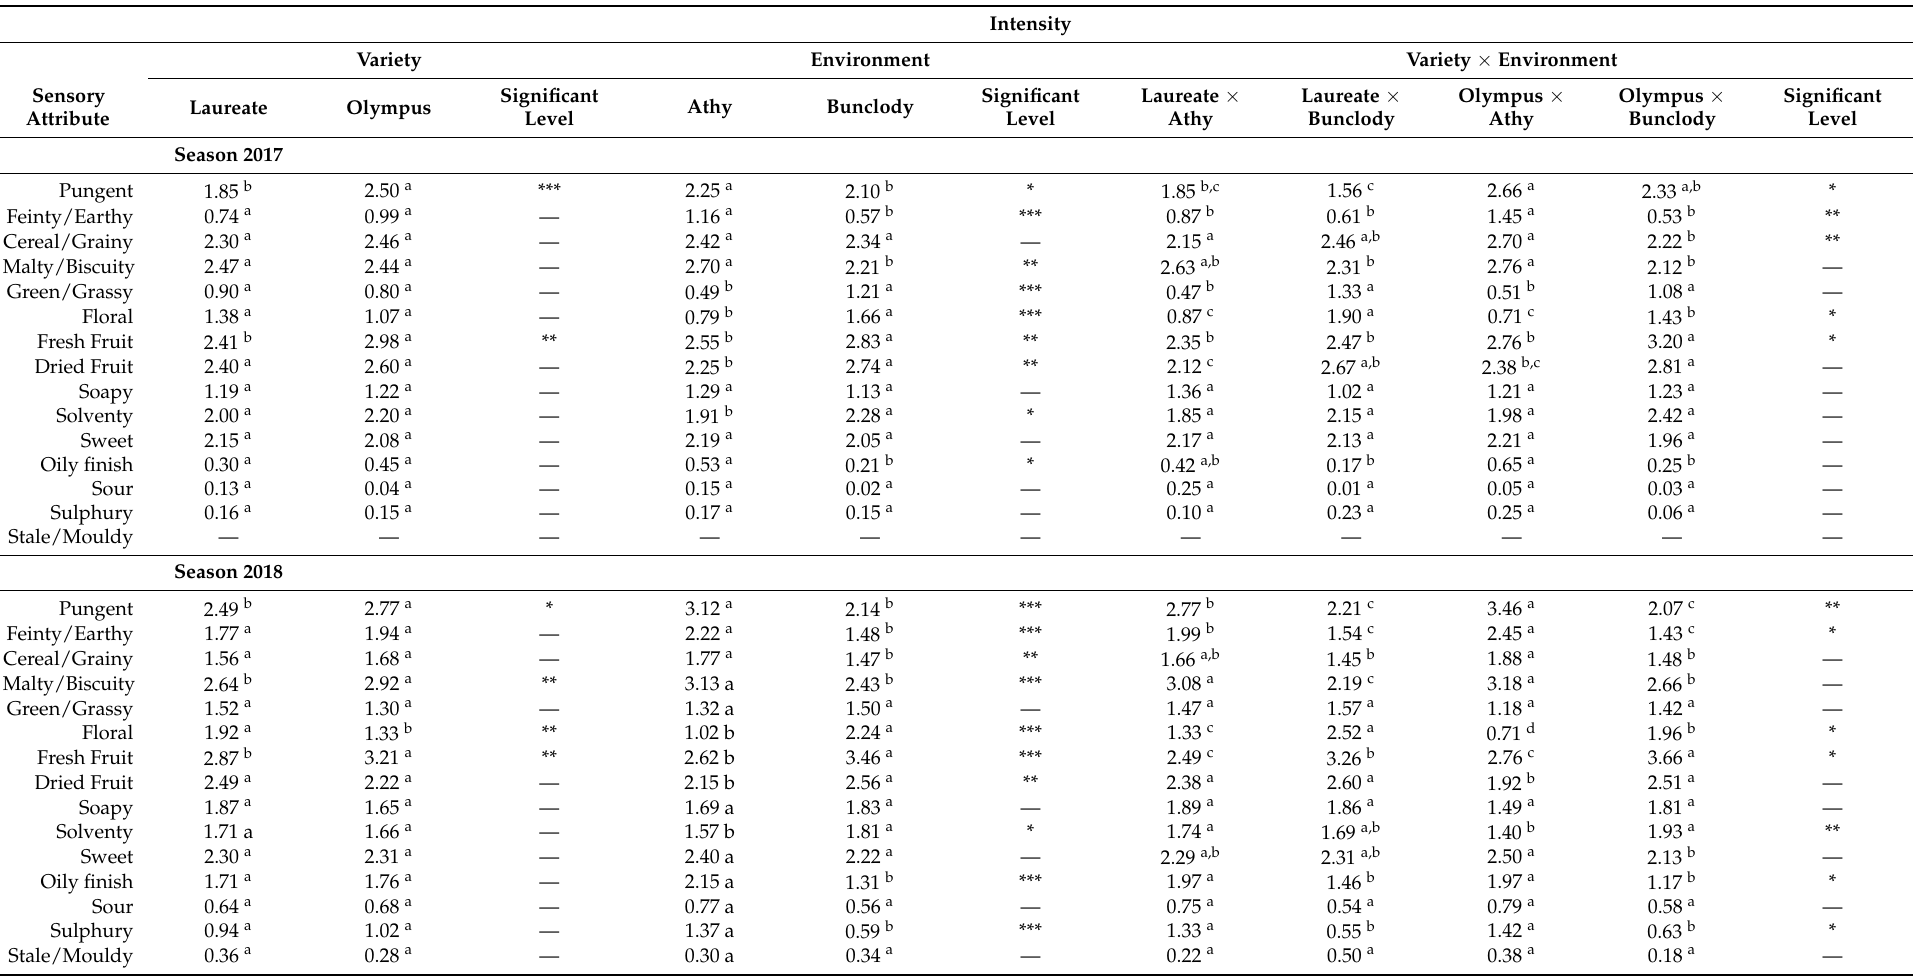
Table 3. Mean separation analysis and significance level of main effects and key interaction terms in the analyses of variance (ANOVAs) on sensory descriptors from new make spirit samples from two varieties (Laureate and Olympus) grown in two environments (Athy and Bunclody) during 2017 and 2018 seasons. Intensity Variety Environment Variety ×